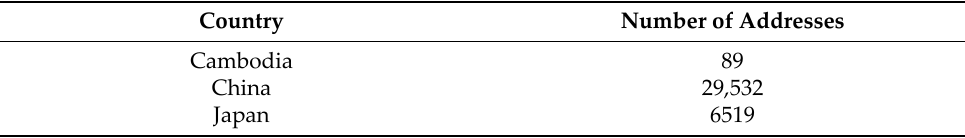
Table 5. Number of manufacturing addresses by country.